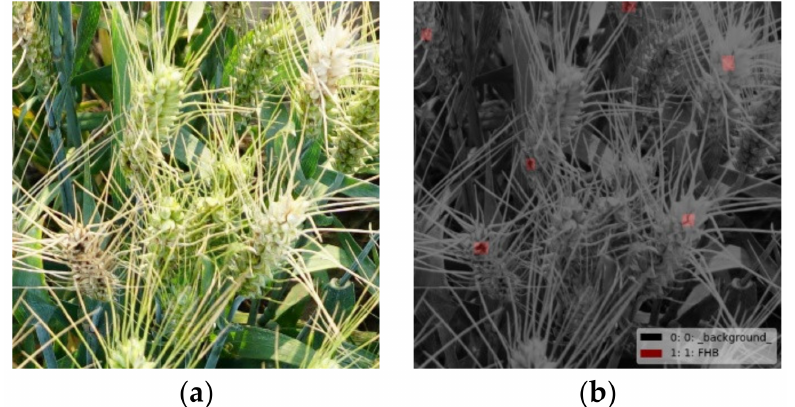
Figure 3. The annotation results of diseased wheat ear image. ( a ) The original image. ( b ) PNG gray